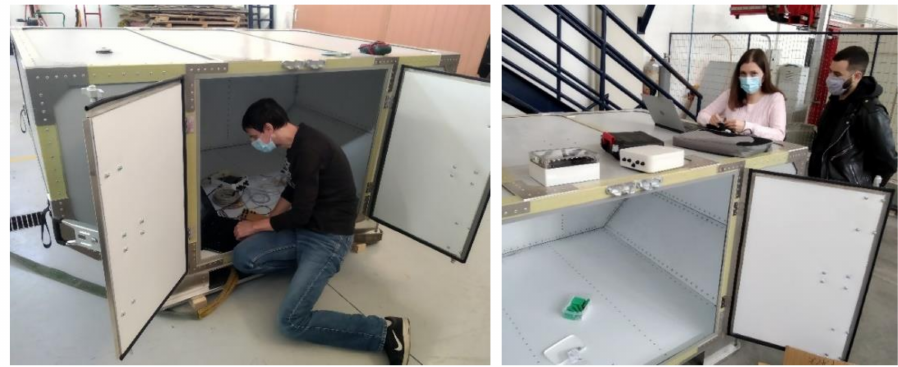
Figure 11. The integration and field testing team and the RMC during integration.